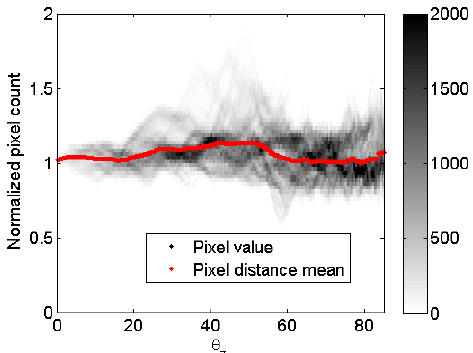
Figure A2. Pixel-by-pixel USI 1.7 signal for red, green, and blue divided by USI 1.8 signal ( v 7 /v 8 in Eq. 8) vs. sky imager zenith angle for an overcast sky. The grayscale shows the number of oc- currences and the red line shows the mean. Since laboratory cali- brations for USI 1.8 were not available, field data from an adjacent imager that was lab-calibrated (USI 1.7) were used to reduce vi- gnetting for USI